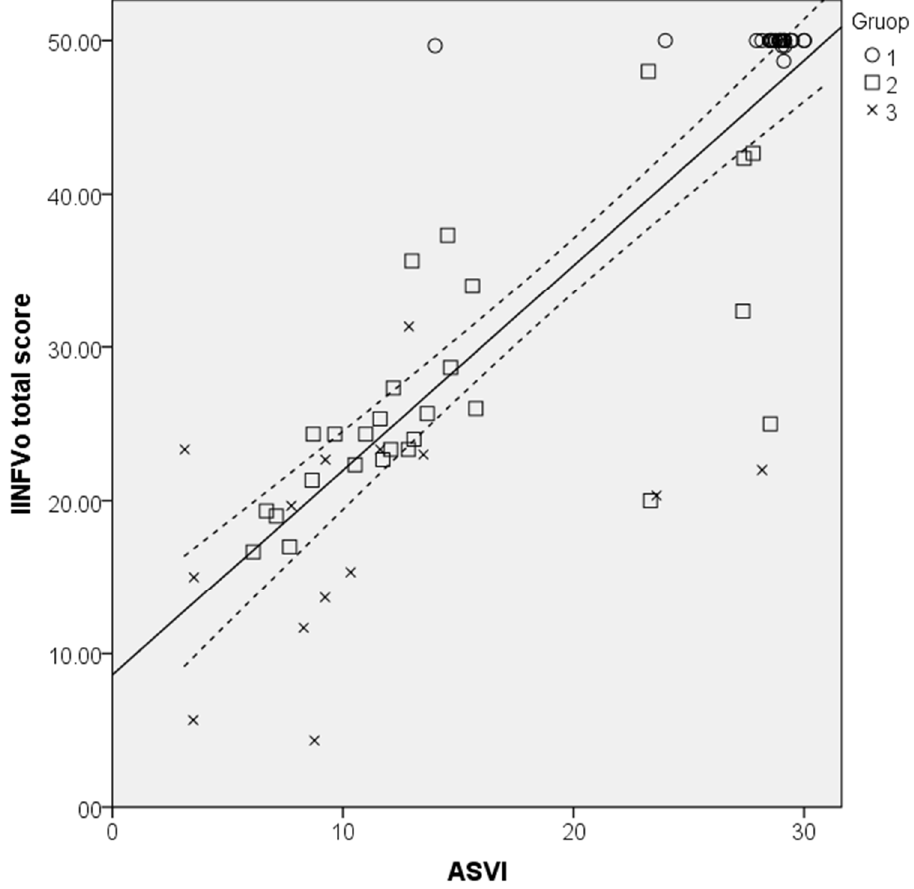
Figure 11. Scatterplot illustrating the correlation between the Impression, Intelligibility, Noise, Fluency, and Voicing perceptual rating scale (IINFVo) and the acoustic substitution voicing index (ASVI) with a 95% confidence interval.